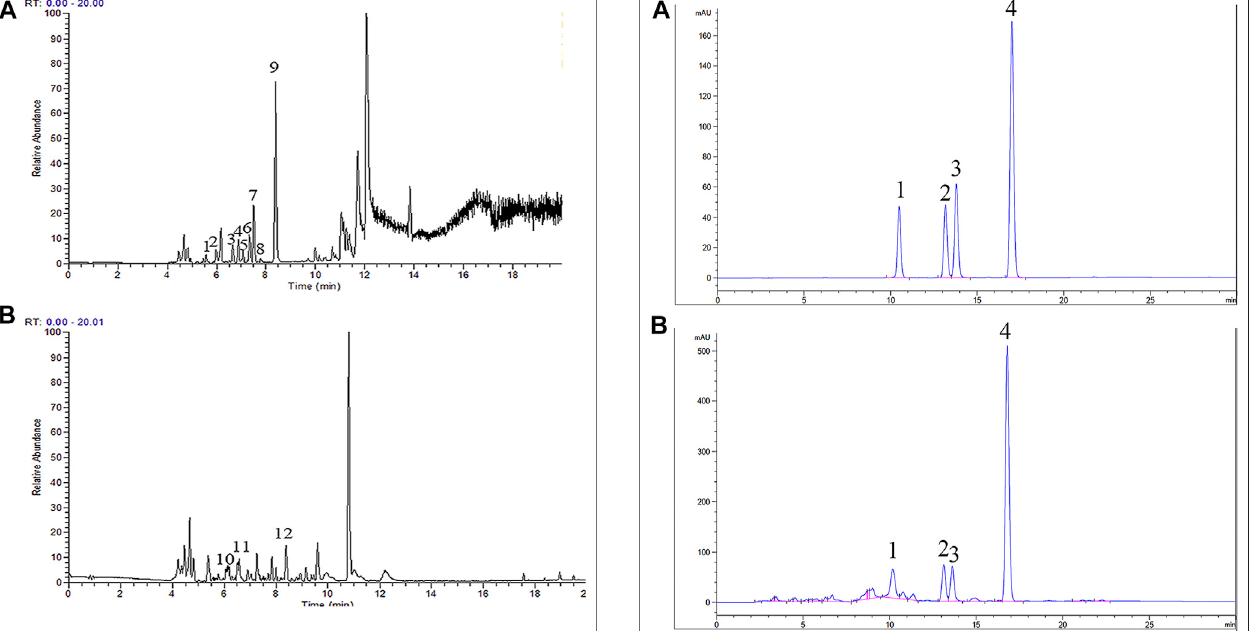
FIGURE 1 | UHPLC-Orbitrap-MS spectrometry of TAN. Positive(A): Salvia miltiorrhiza new quinone B (1), Tanshinaldehyde(2), Dihydrotanshinone I(3), Tanshinone IIB (4), dehydromiltirone (5), Tanshinone Ⅰ (6), Cryptotanshinone (7), Methylenetanshinquinone (8), Tanshinone IIA (9), Negative(B):Danshin spiroketal lactone (10), Danshenxinkun A (11), Alpha- (3,4-dihydroxyphenyl)lactic acid (12).